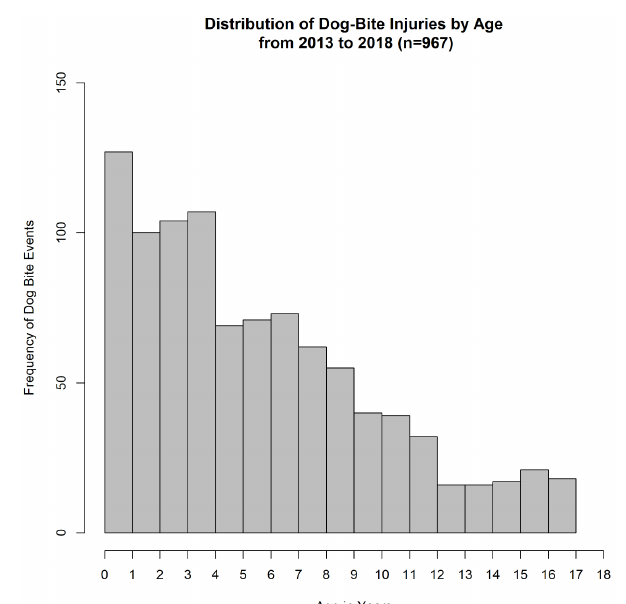
Figure 1. Distribution of dog bite injuries by